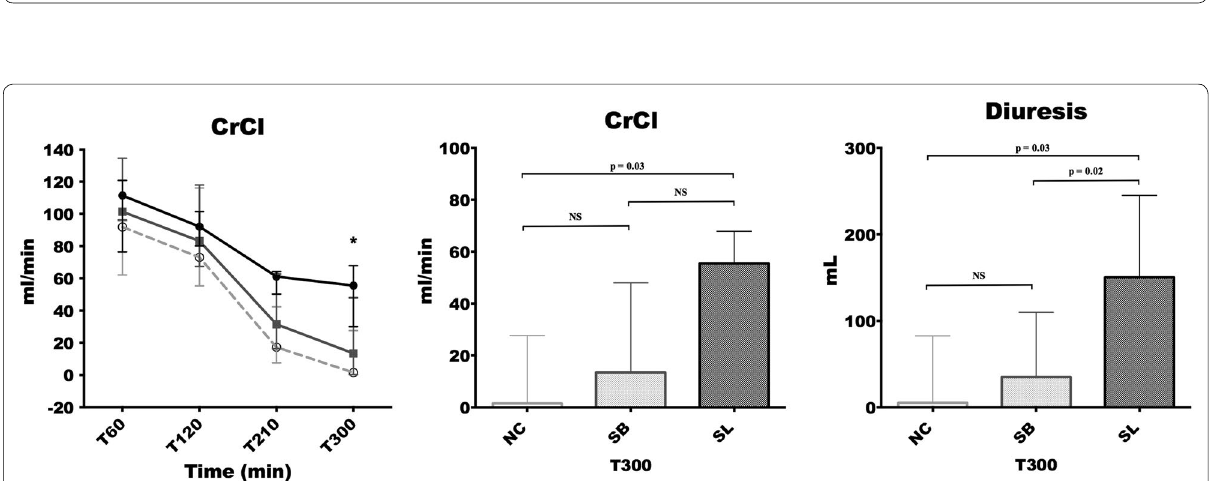
Fig. 4 Changes in interleukin‑6 and TNFα in the three groups. Open circles and dotted line: NC group ( n ( n 5); closed circles and black line: SL group ( n = SB versus SL. & p < 0.05, NC versus SB